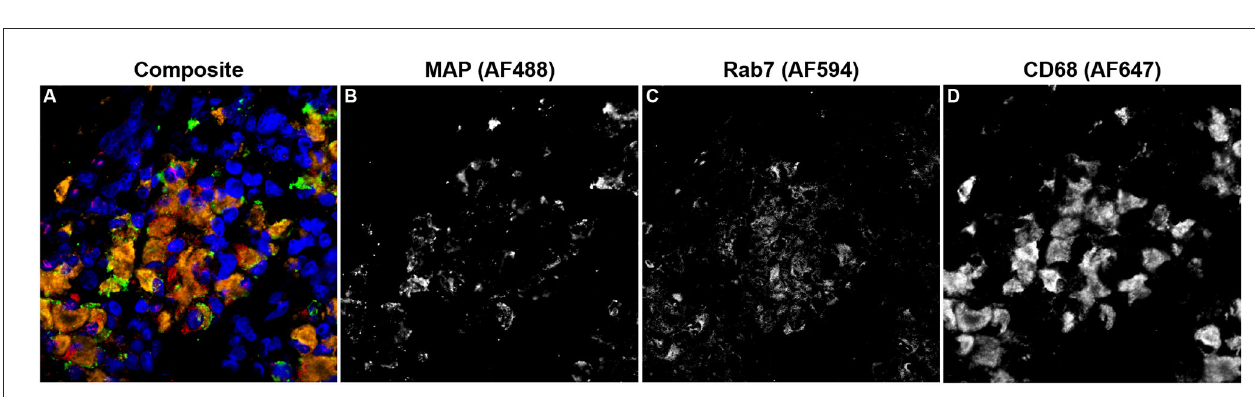
FIGURE6 Confocal microscopy image of frozen mid-ileum tissue section from a cow with clinical stage paratuberculosis. The composite image (A) shows Mycobacterium avium subsp. paratuberculosis (MAP; green) detected using an AF488 secondary antibody and excited on the 488nm laser (B) . Rab7 (red) expression was detected through excitation of an AF594 secondary antibody on the 561nm laser (C) . CD68 (orange) was labeled with an AF647 secondary antibody and excited on the 641nm laser (D) . Nuclei (blue) were counterstained using DAPI which was excited on the 405nm